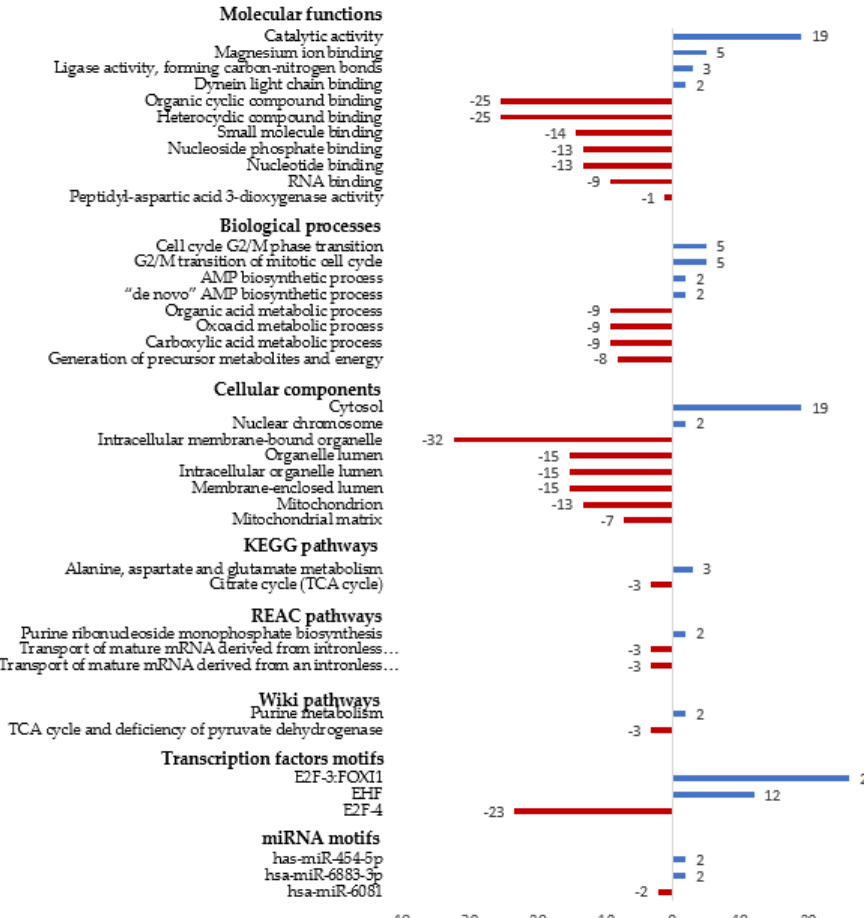
Figure 3. Gene ontology analysis of proteins with differential abundance in HepG2 cells after treatment with EO. In blue proteins only detected after treatment with EO. In red, proteins are only detected in control cells.